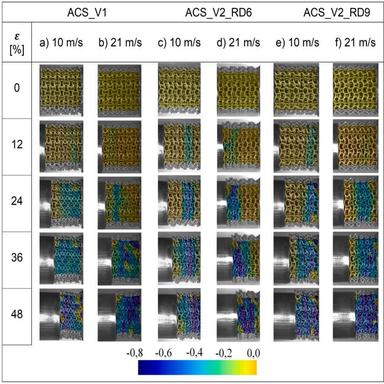
The longitudinal strain field deformation evolution of ACS structures under DYN loading.